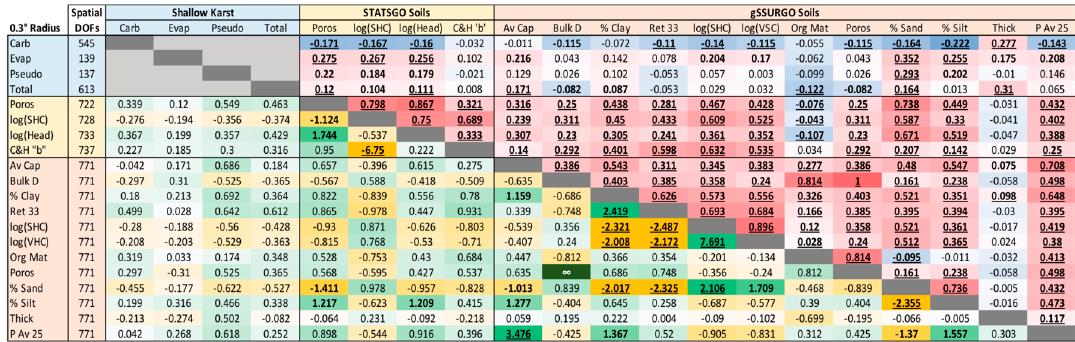
Figure 2. Above the diagonal with a blue-to-red color scale: R ( σ A , σ B ) , the degree to which the magnitudes of local variability are spatially synchronized across the domain between the pair of parameters; below the diagonal with a yellow-to-green scale: the inverse of the coefficient of variation of within-radius correlations (CV − 1 ) across the domain. For R ( σ A , σ B ) , values significant at the 95% confidence level based on indicated spatial degrees of freedom are bold, 99% confidence are underlined. For CV − 1 , values ≥ 1 are bold, ≥ 2 are underlined.